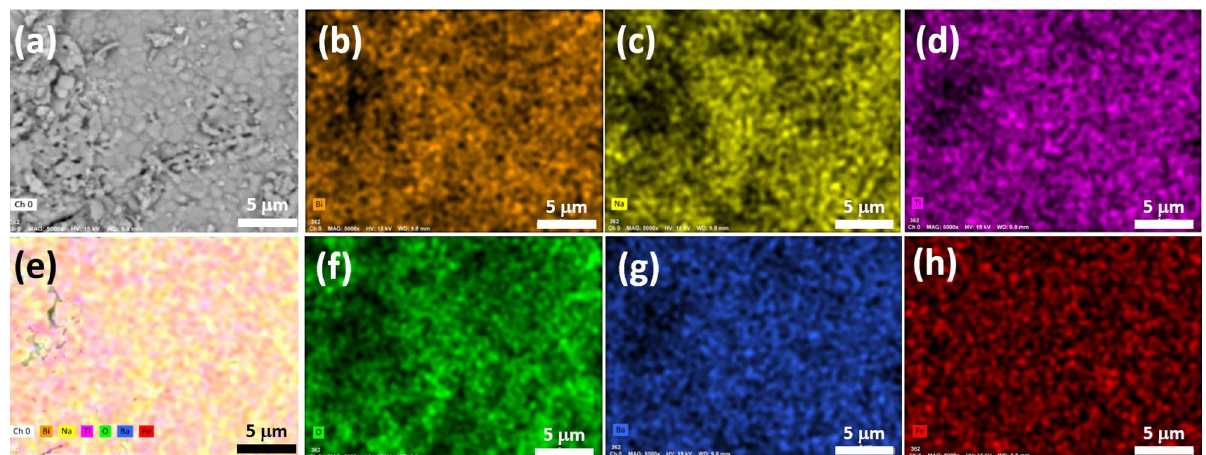
Figure 2. (a) Selected area for the chemical mapping of 9 mol.% BaFeO 3−δ -modified Na 0.5 Bi 0.5 TiO 3 materials; (b) total chemical element distribution in samples; and (c)–(h) partial chemical element maps of Bi, Na, Ti, O, Ba, and